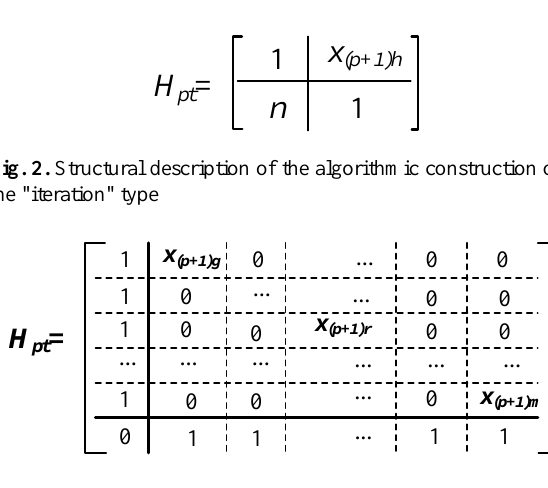
Fig. 3. Structural description of the algorithmic construction of the "alternative"